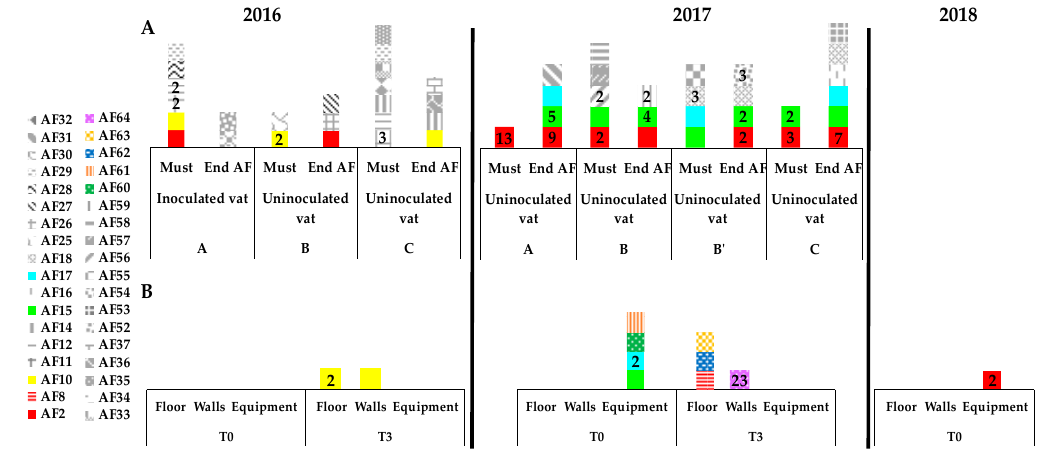
Figure 3. S. cerevisiae strains identified ( A ) in followed vats during the fermentation and ( B ) on winery surfaces during the three vintages. Only the number of isolates per strain ≥ 2 is noted.